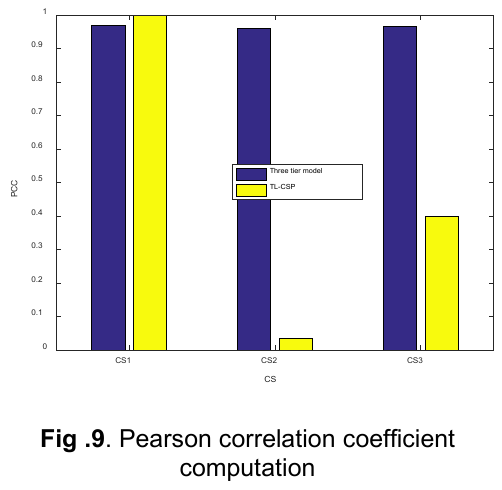
Fig .6. MAE computation of cloud service 1 Fig. 7. MAE computation of cloud service 2